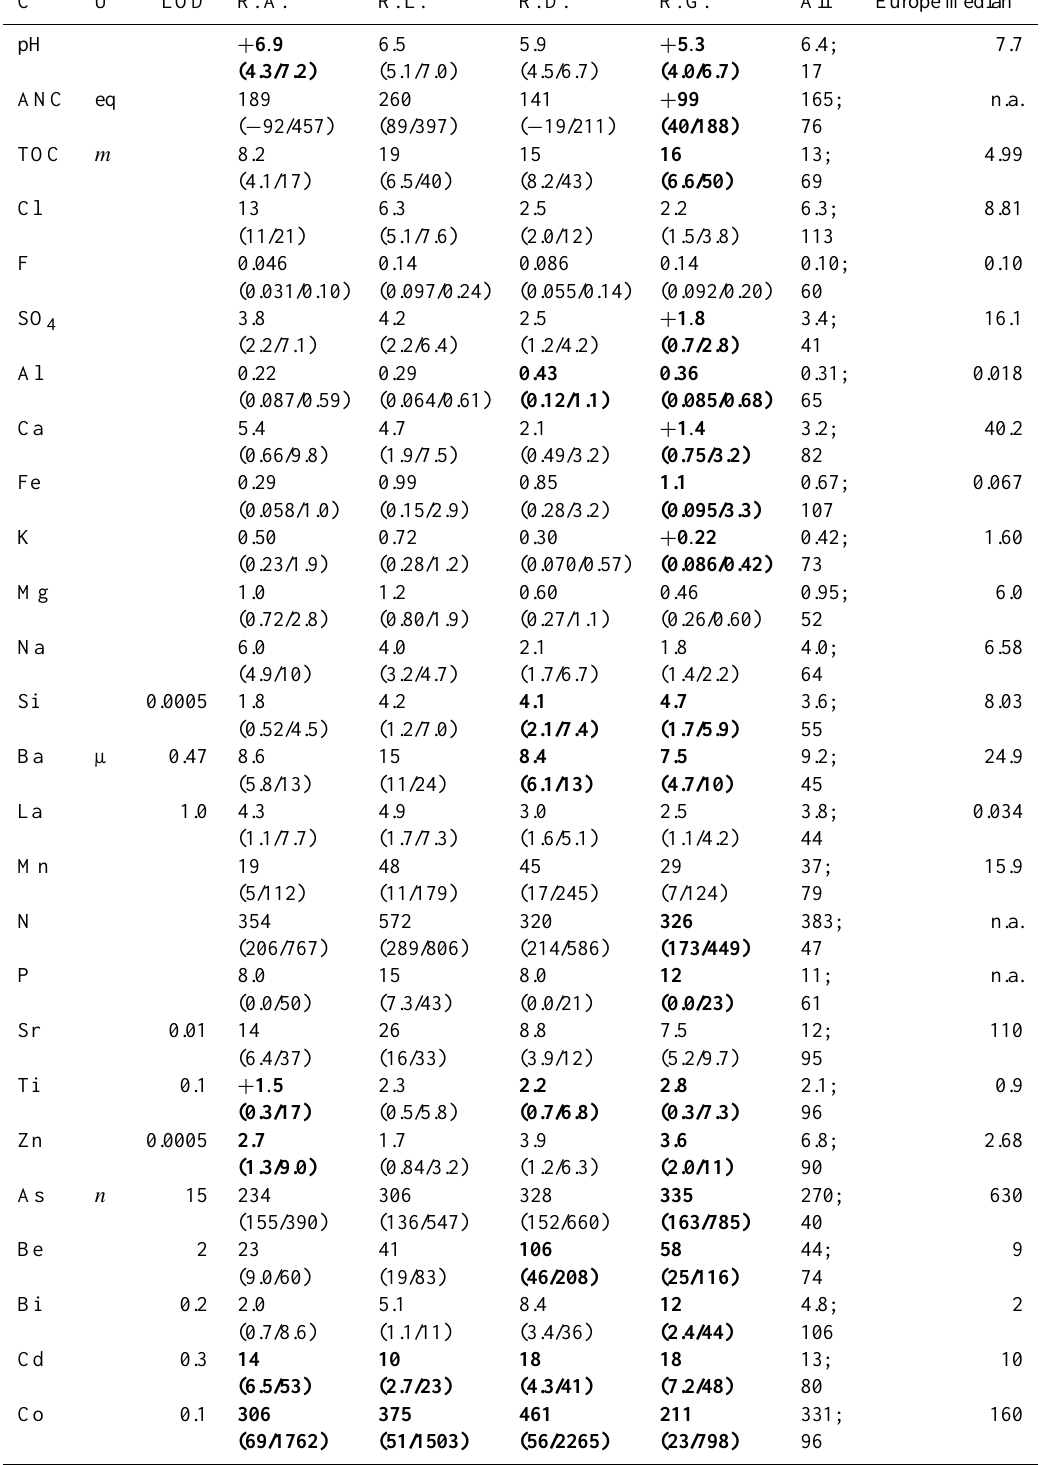
Table 2. Chemistry results for each catchment. Median with 5th and 95th percentiles in parentheses. U is units, where n is ngL − 1 , µ